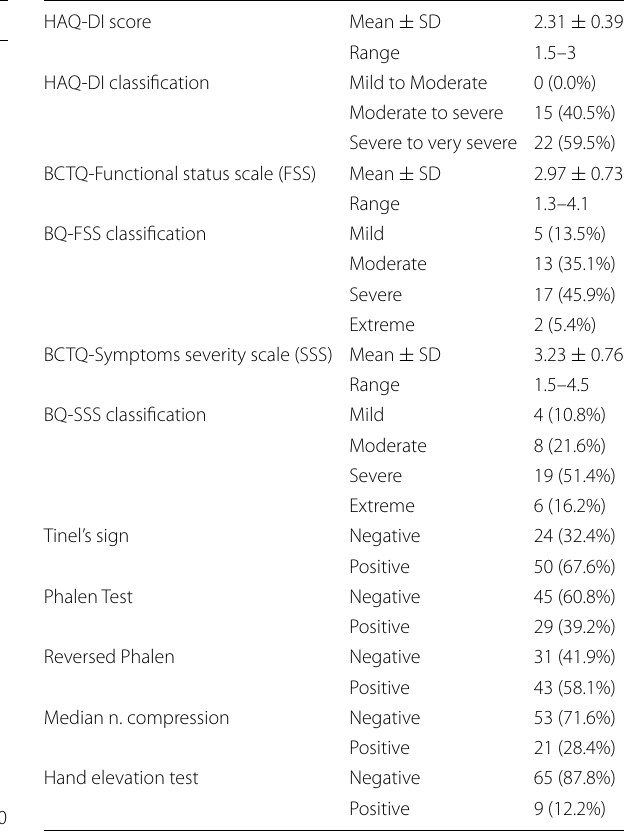
Table 1 Demographic and clinical data of the studied